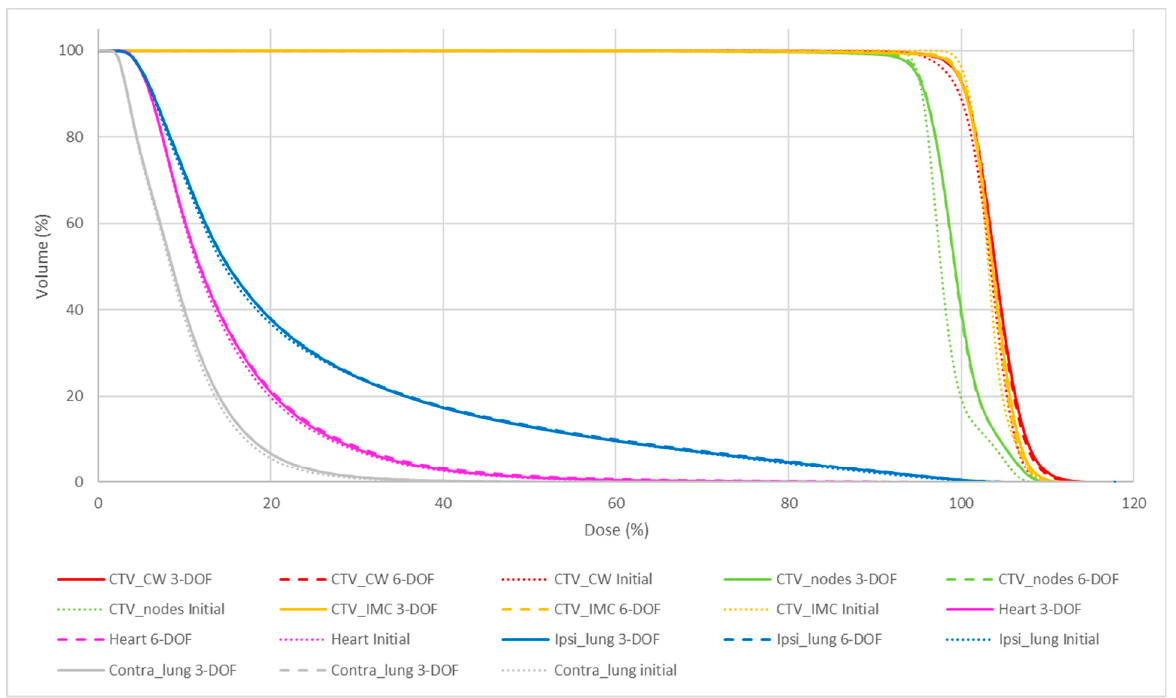
Figure 5. Dose volume histograms for the initial plan (dotted lines), 6-DOF (dashed lines), and 3- DOF (solid lines) CBCT plans for breast irradiation. N.B. The breast CTV includes the tumor bed (100% of the prescribed dose), which was not evaluated in this study.